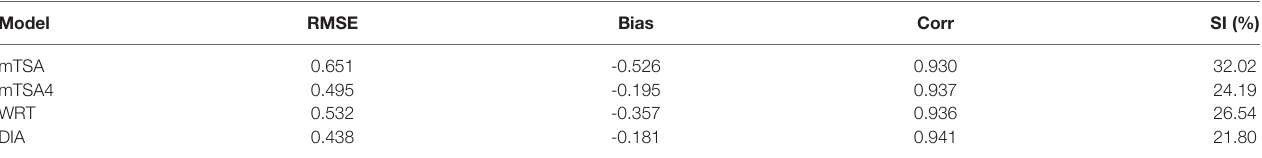
TABLE 1 | Statistics for Hs (m) from WW3 wave model compared to measurements at 14 buoys along or near the storm track of Hurricane Teddy, for root mean square error (RMSE), bias, correlation coef fi cient (corr) and scatter index (SI). Model